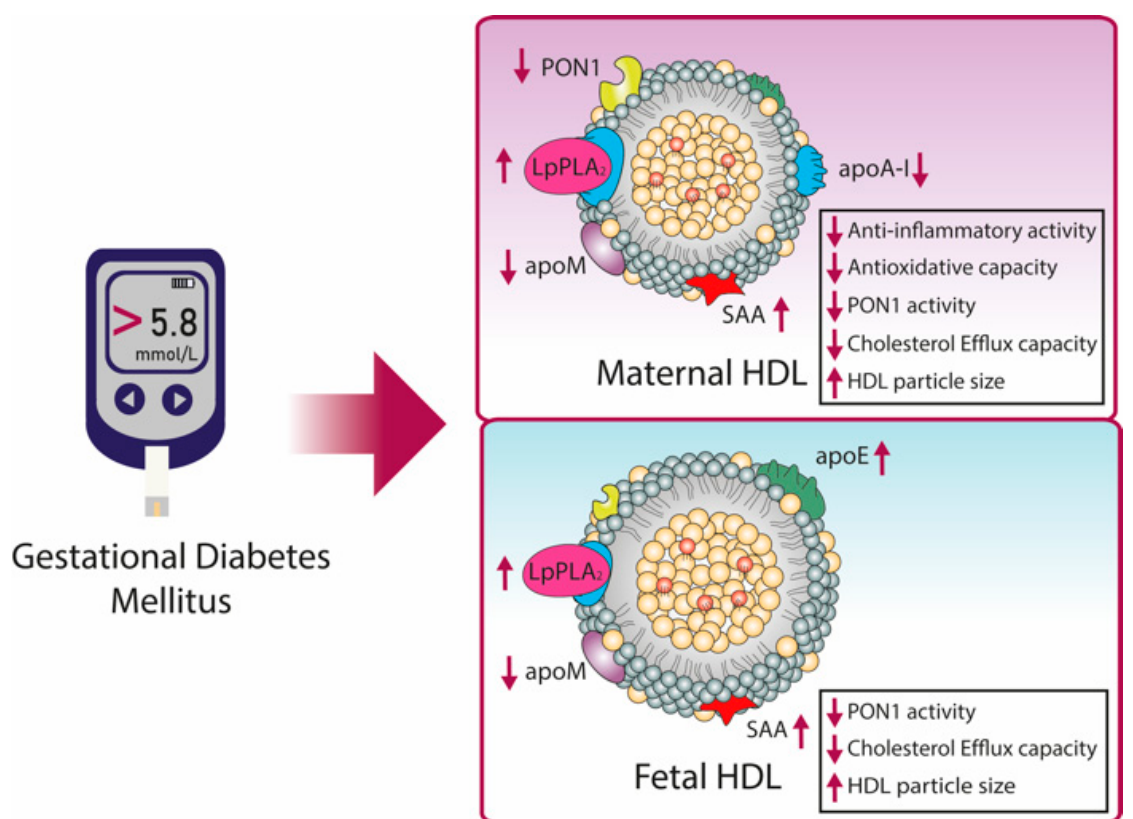
Figure 4. GDM affects maternal and fetal HDL composition and function. Changes are indicated with purple arrows. In maternal HDL, a decrease in PON1 activity and mass, apoM, and apoA ‐ I content were observed, whereas SAA and LpPLA 2 were increased. These changes in HDL composition were associated with reduced anti ‐ inflammatory and anti ‐ oxidative activity and reduced cholesterol efflux capacity. Fetal GDM ‐ HDL showed the same alterations in PON1 and LpPLA 2 activity, apoM and SAA content, and further increased apoE content. GDM was also accompanied by the increased particle size of both maternal and fetal HDL. HDL, high ‐ density lipoprotein; apo, apolipoprotein; PON1, paraoxonase 1; LpPLA 2 , lipoprotein ‐ associated phospholipase A2; SAA, serum amyloid A.